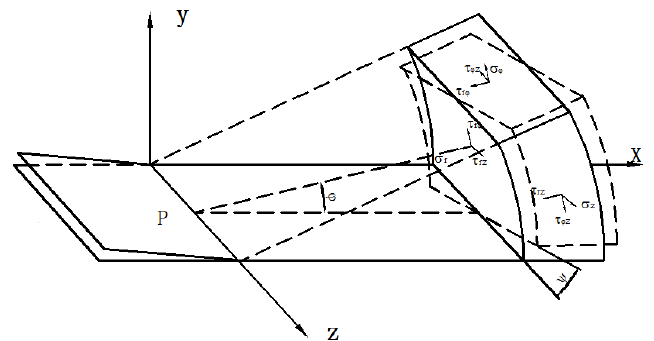
Figure 13. Stress field at crack tip.